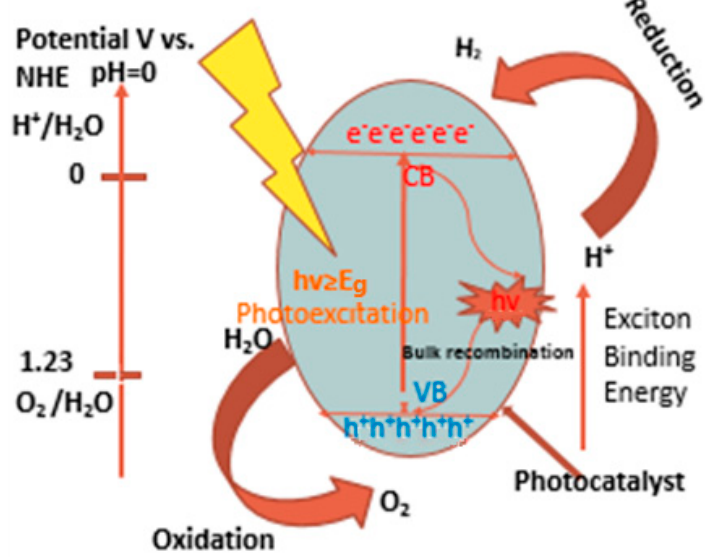
Figure 1. Schematic illustration of the mechanism of photocatalytic water splitting [14].